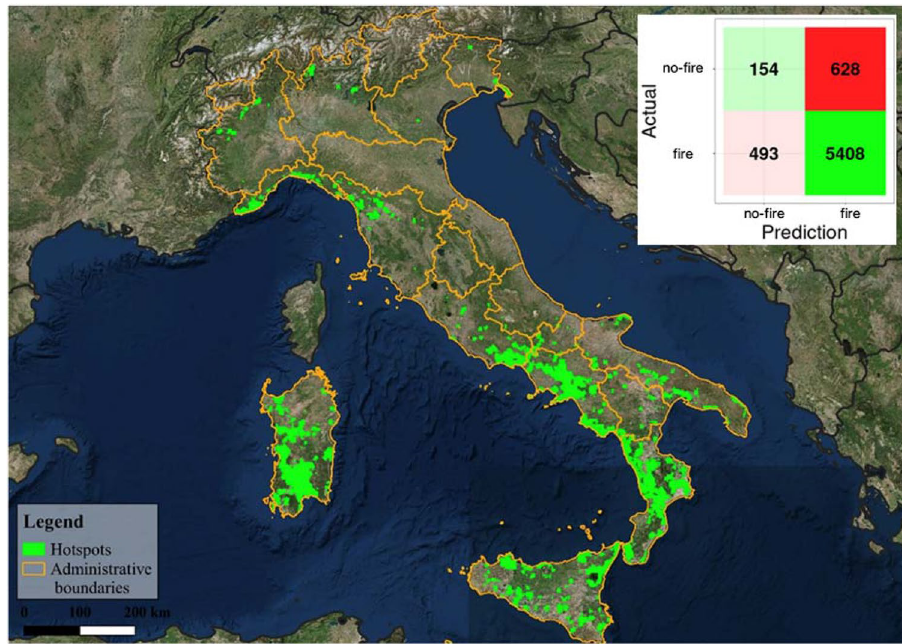
for diagonal terms and red scale for off-diagonal terms in the confusion matrix emphasize the impact of the matrix terms on the overall ratio. The map was produced on QGIS using the "new layout" feature. The map was produced by using the plot.raster function from "raster" R